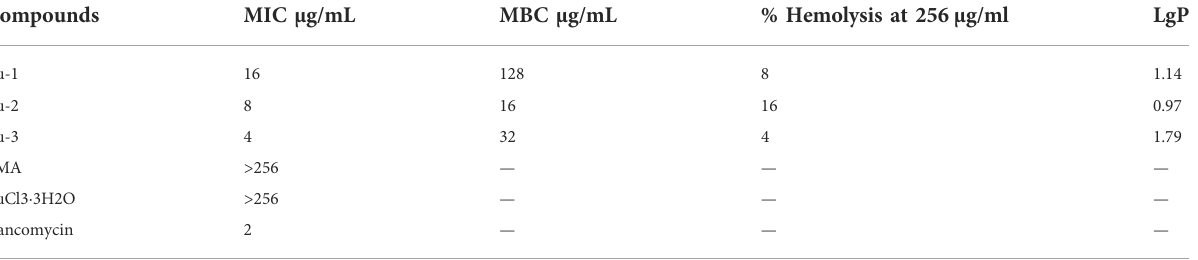
TABLE 1 In vitro Antimicrobial Activities Against S. aureus and Hemolytic Activities of compounds. Compounds